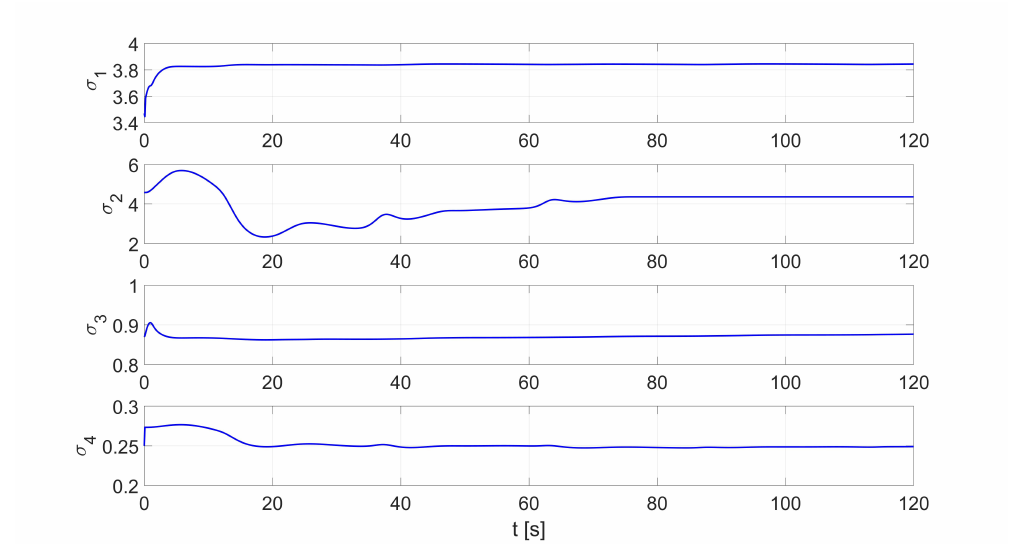
Figure 23. Distribution of parameters identified online by the RLS method with random values of initial parameters in the laboratory test.